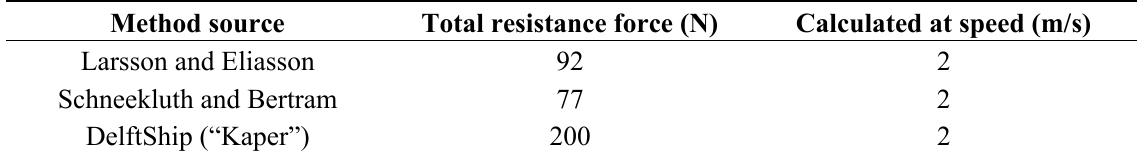
Table 3. Resistance force calculated by different empirical methods.